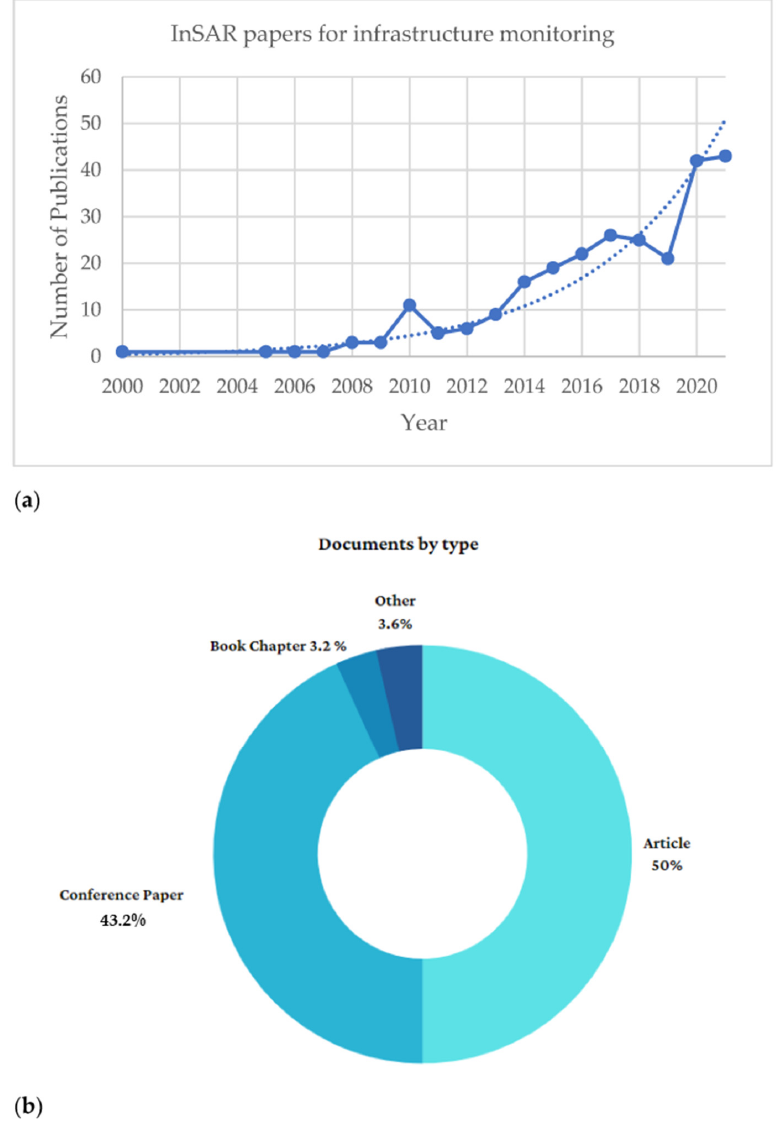
Figure 1. ( a ) Scientific contributions per year related to the applications of InSAR to infrastructure monitoring. ( b ) Documents by type. Source: Scopus (www.scopus.com), accessed on 1 September 2022 [36].